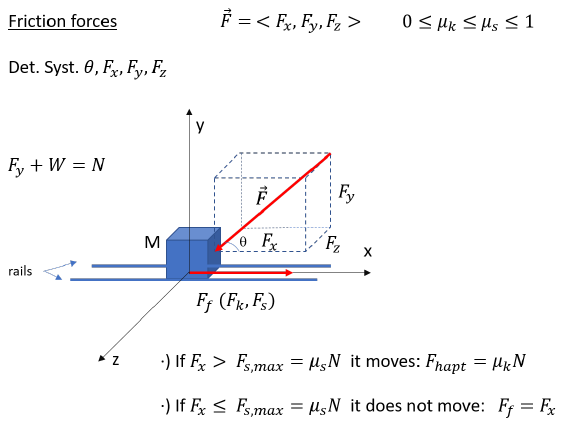
Figure 2. Sketch of the displacement of a box in a track when a force is applied with a haptic device. The mass of the box as well as the static and dynamic frictional coefficients can be modified at